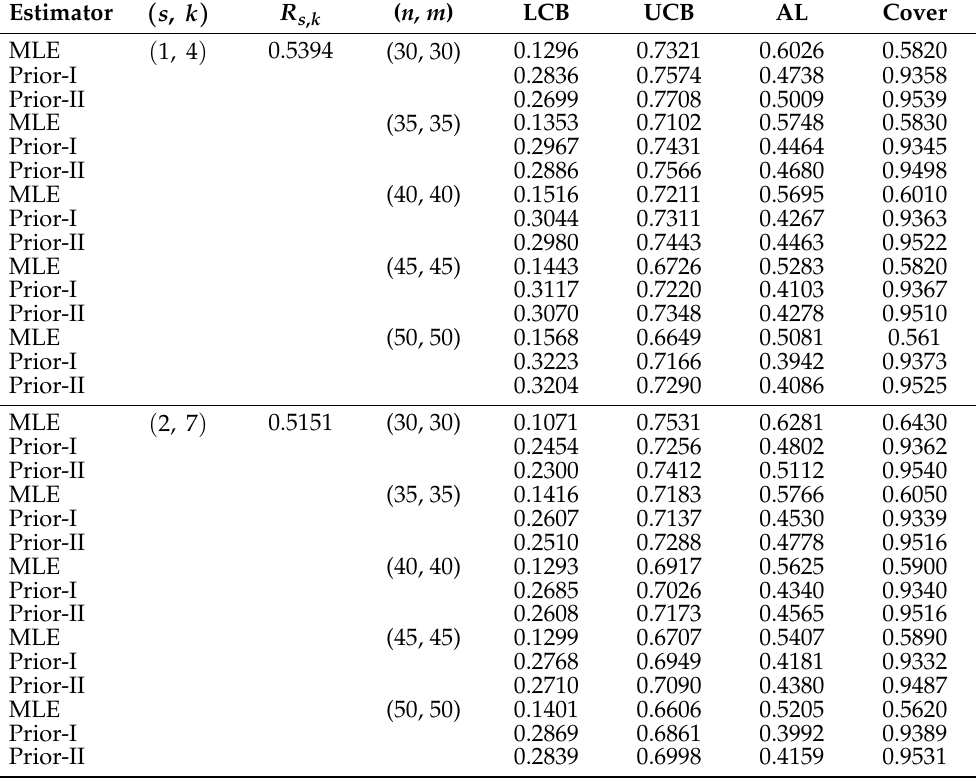
Table 8. The 95% confidence intervals of R s , k for Case 1, ( α , λ 1 , β , λ 2 ) = ( 2, 2, 2, 3 ) , and T = 5.